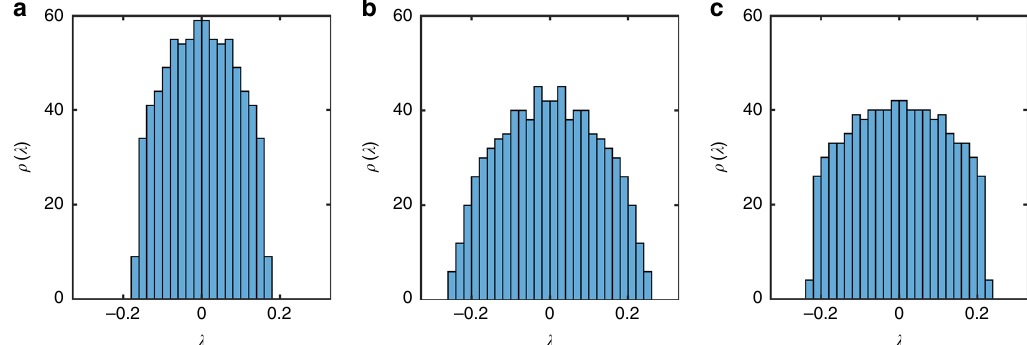
Fig. 1 Lyapunov spectrum for a wavefunction MPS representation of Ising model dynamics. a Non-integrable case with J = 1, h x = 0.5, h x = 1. b Integrable case with J = 1, h x = 0.5, h x = 0. c Nearly Integrable case with J = 1, h x = 0.5, h x = 0.1. In all cases, the spectrum is obtained for an MPS representation of the wavefunction at bond order D =